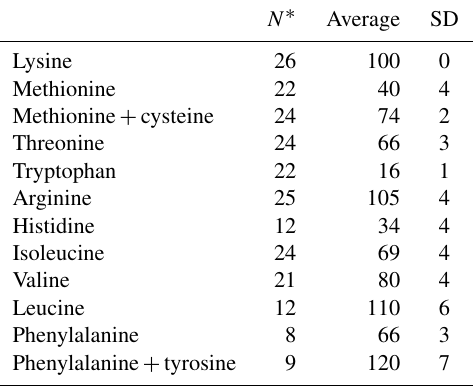
Table 6. IAAR of growing meat-type chickens as derived by di- rectly relating observed amino acid efficiency data according to Eq. (5) (Wecke and Liebert,